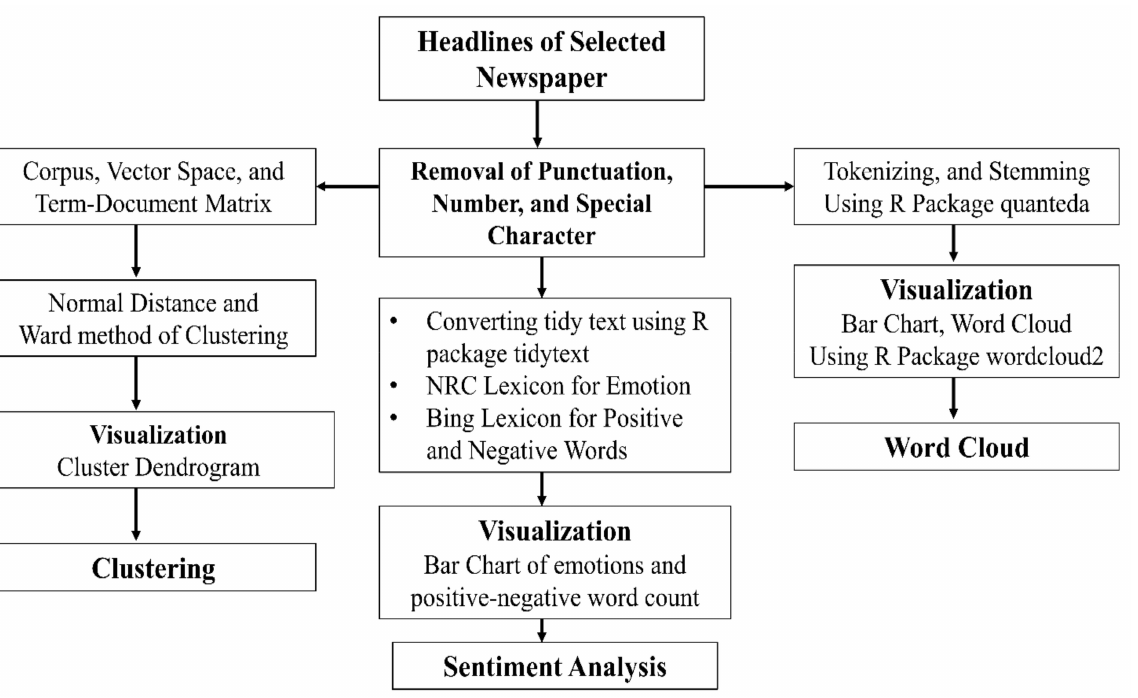
Figure 3. Flowchart of the working